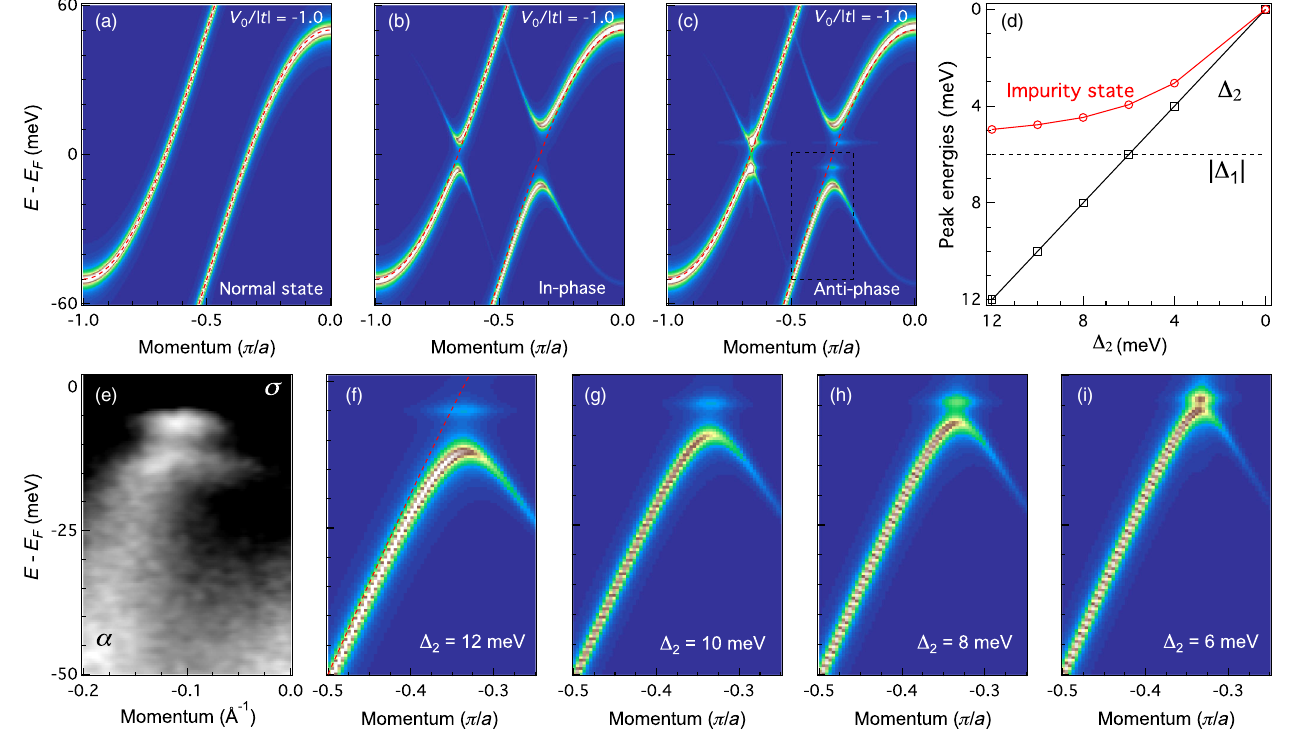
FIG. 4. (a) – (c) Numerical simulations of the spectral weight for a system with an impurity interacting with two dispersive bands Δ ≠ 0 ), and in the antiphase SC state according to Eq. (3) in the normal state ( Δ 1 ¼ Δ 2 ¼ 0 ), in the in-phase SC state ( Δ 1 ¼ 1 2 2 Δ ≠ 0 ), respectively. In all cases, we use V = j t j ¼ − 1 . The dashed red lines represent the electronic dispersion in the normal ( Δ 1 ¼ − 1 2 0 2 state. (d) Simulation of the energy position of the in-gap impurity state as a function of j Δ 2 j for a fixed j Δ 1 j . (e) Zoom on the impurity state found experimentally near the α band of Ba 0 K 0 Fe 2 As 2 . (f) – (i) Numerical simulation of the zoom near the impurity state . 6 . 4 corresponding to the dashed box from (c) (antiphase SC), as a function of j Δ 2 j , for j Δ 1 j ¼ 6 meV (antiphase gaps). The dashed red line in (f) represents the bare band